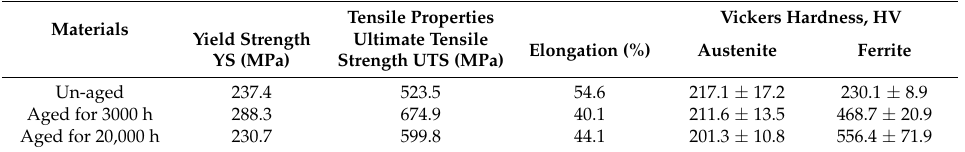
Table 1. Tensile properties and hardness in the un-aged and aged cast duplex stainless steel (CDSS). Materials